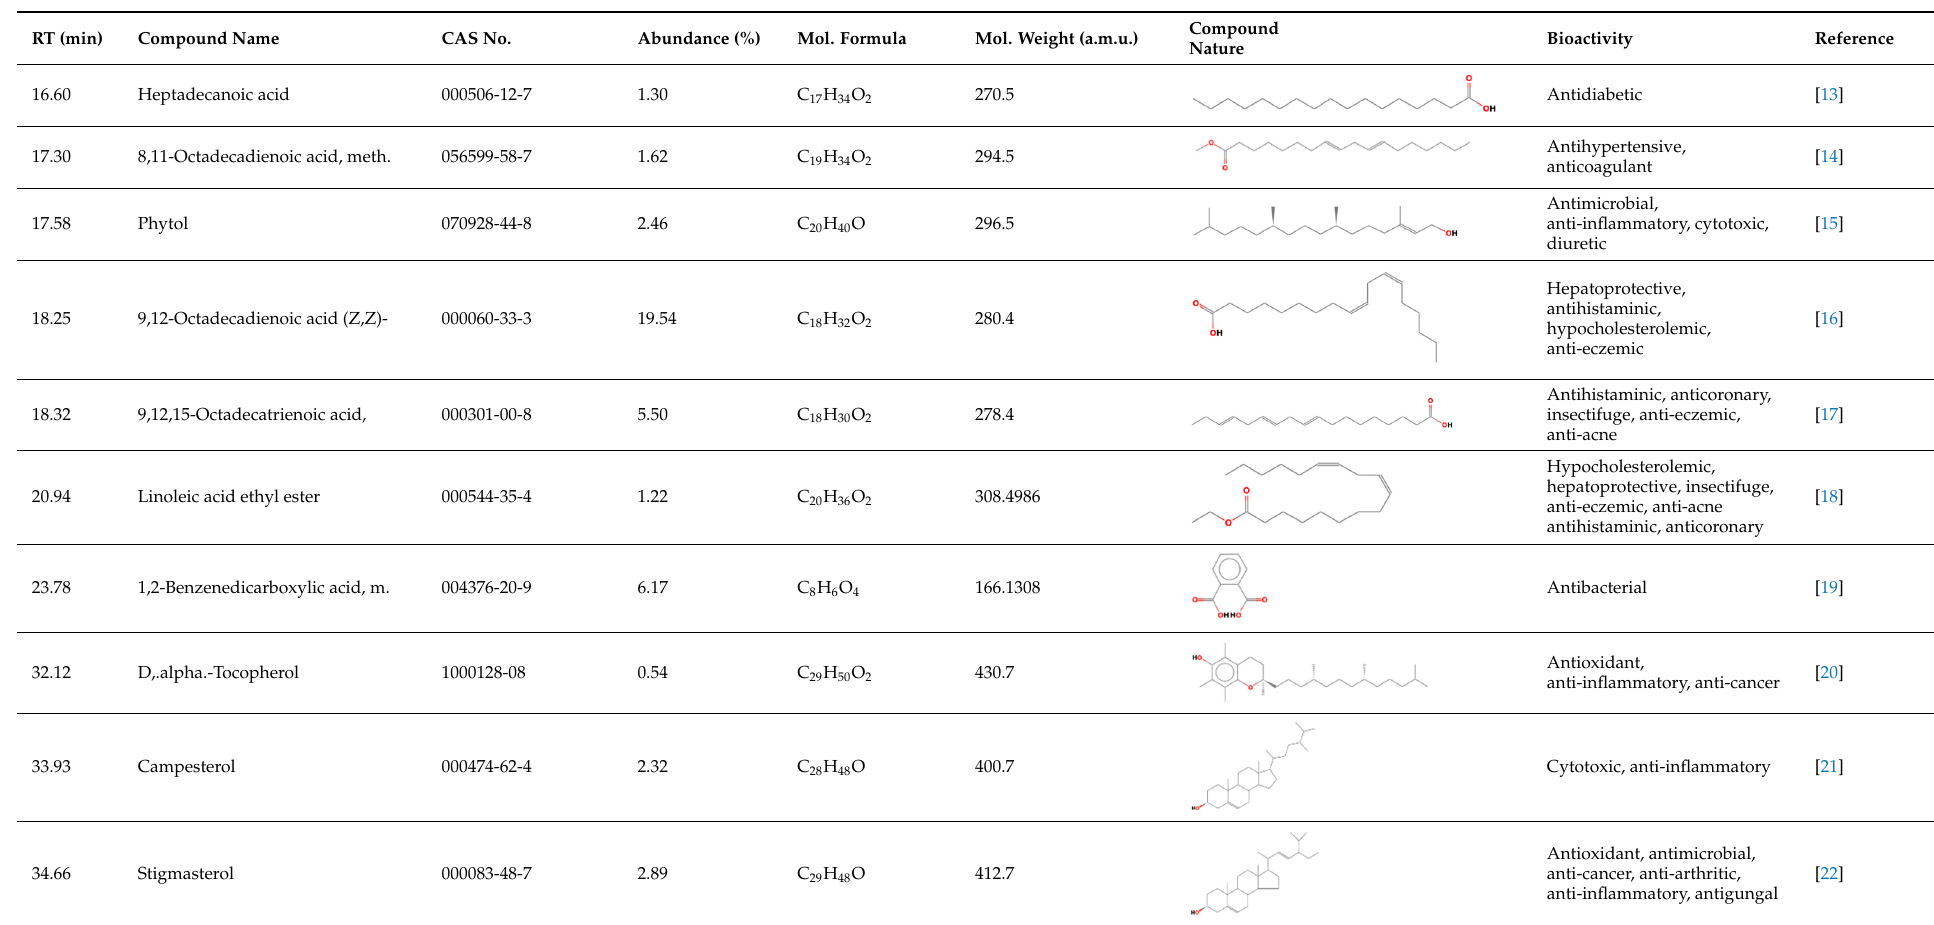
Table 1. GCMS analysis of Monotheca Table 1. GCMS analysis of Monotheca buxifolia. Table 1. GCMS analysis of Monotheca buxifolia. Table 1. GCMS analysis of Monotheca buxifolia. Table 1. GCMS analysis of Monotheca buxifolia .